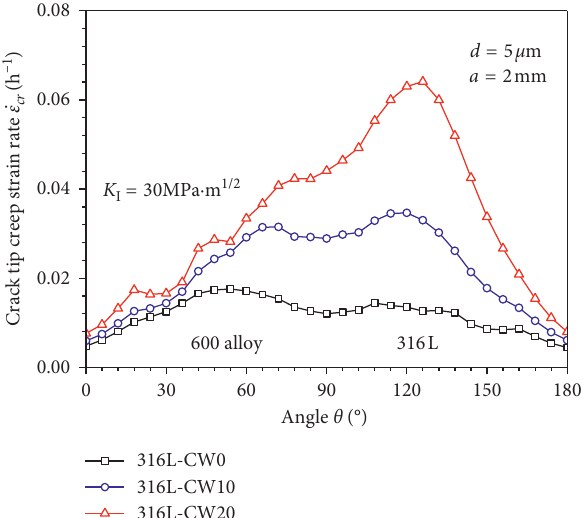
Figure 12: Effect of cold working on the crack growth rate on the fusion line.